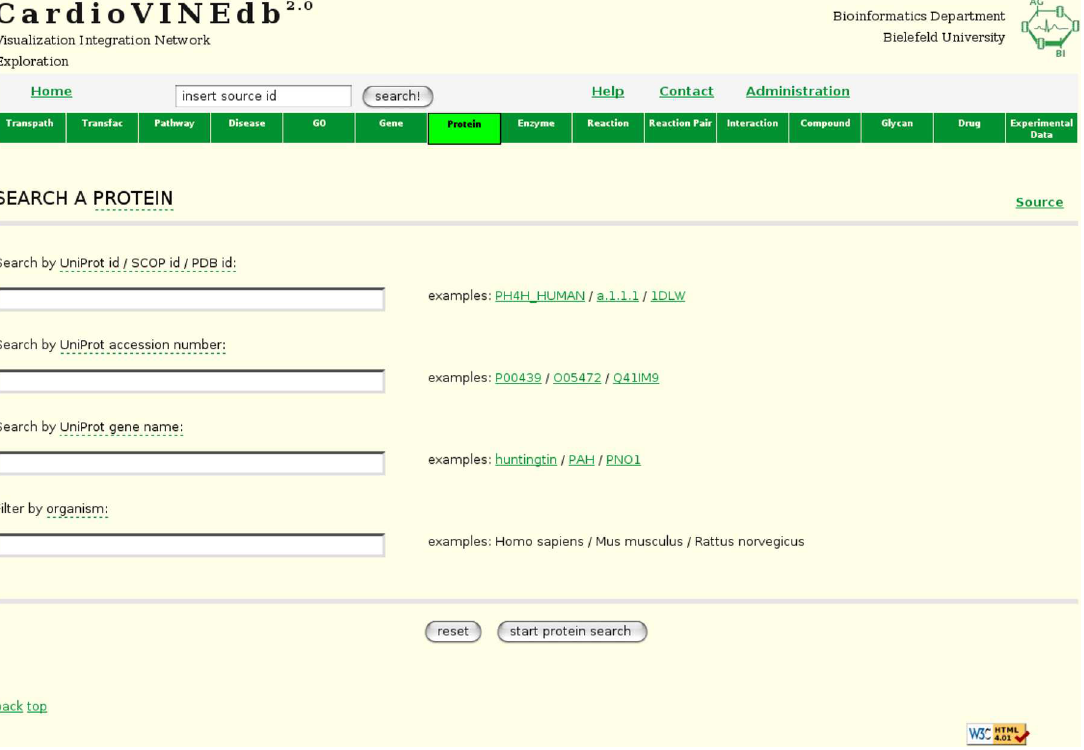
Figure 2: Search form for the Protein domain in